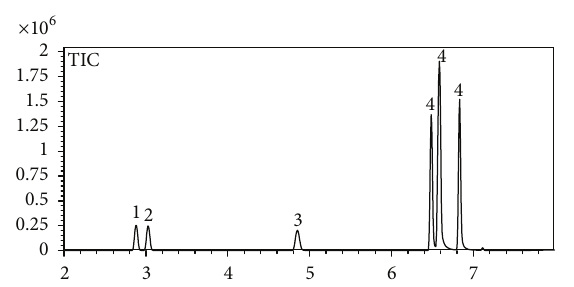
Figure 1: Total ion chromatogram of chlorpyrifos EC spiked with 4.7 g/L of benzene, 4.3g/L of fluorobenzene, and 4.7g/L of toluene (equilibrationtemperatureof120 ∘ C,samplesizeof20 𝜇 L;1,benzene; 2, fluorobenzene; 3, toluene; 4, xylene).